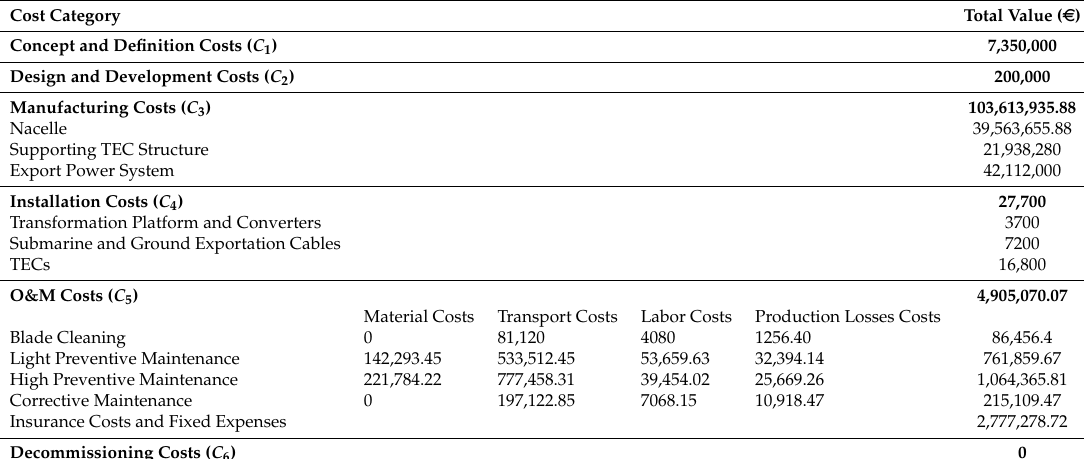
Table 1. Summary of the cost of the tidal farm in the Alderney